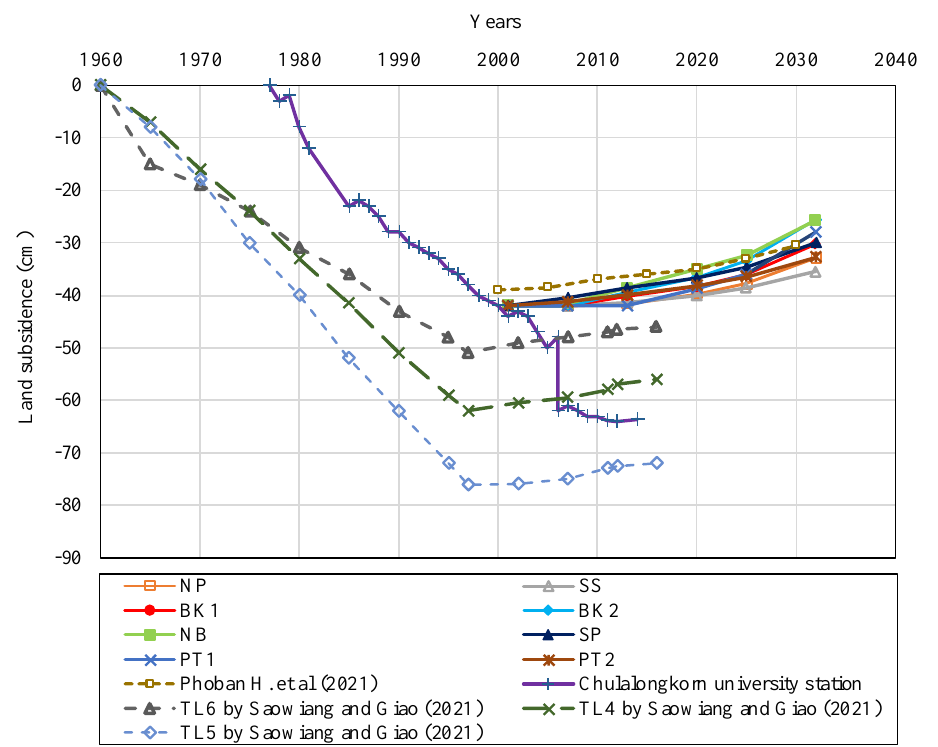
Figure 8. Displacement at each borehole.